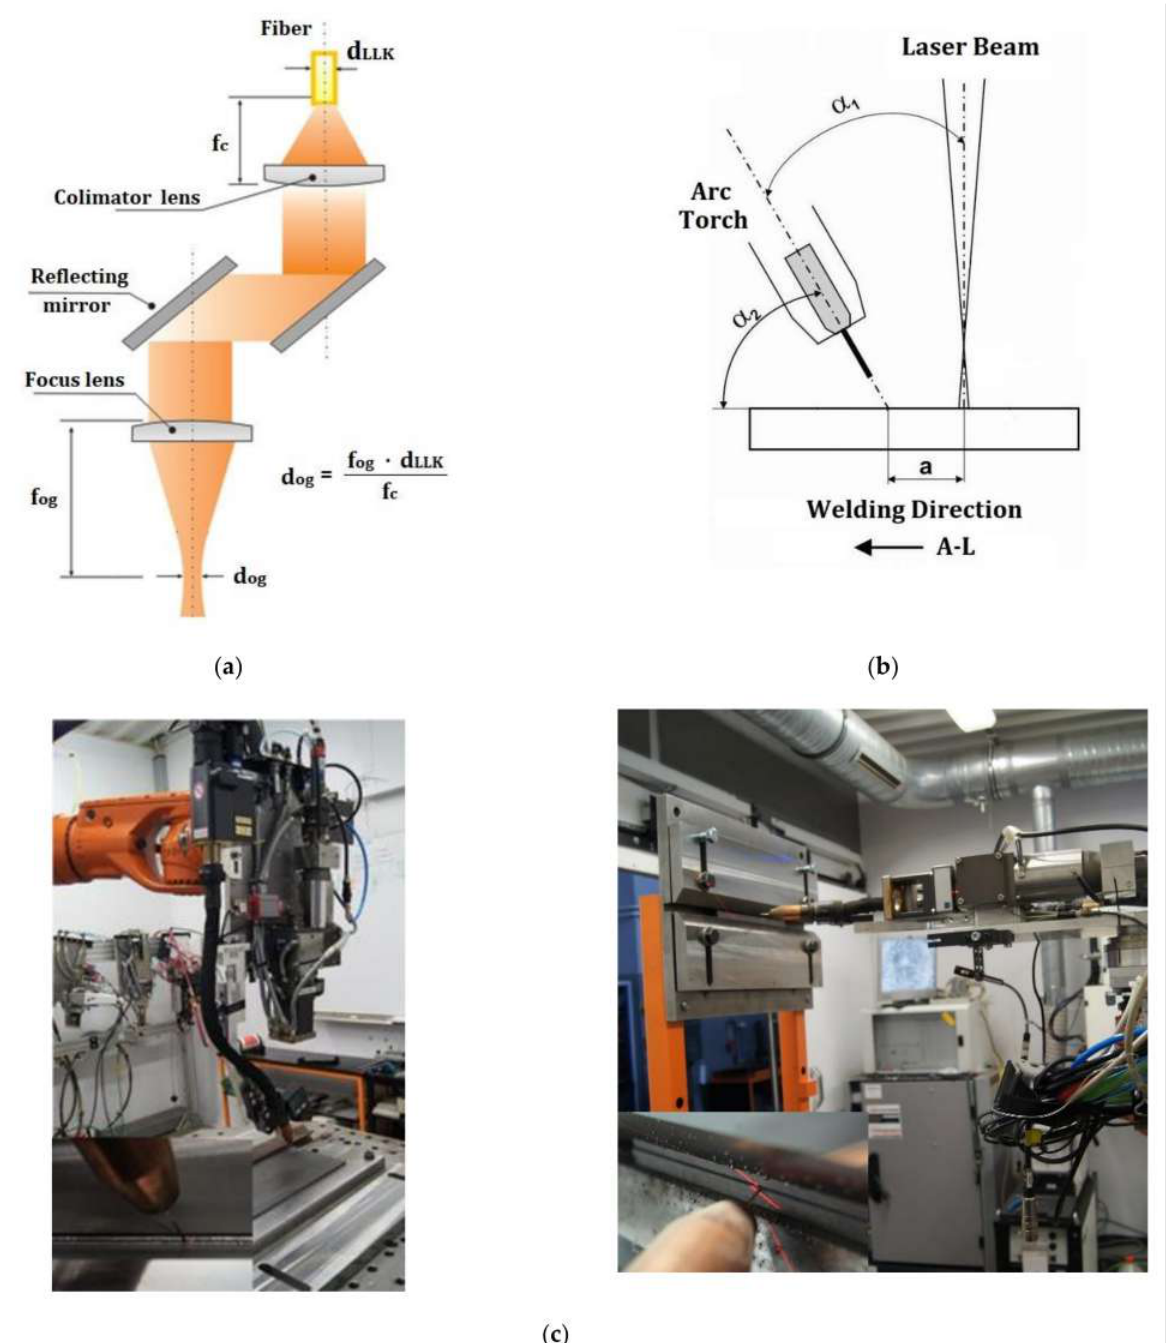
Figure 5. Schematic diagram of the laser optical system as well as the position of the laser beam and electric arc in the hybrid-welding technology: ( a ) laser optical system, ( b ) position of the laser beam and electric arc, and ( c ) processing head inclination during welding in the flat position (PA) and in the horizontal position